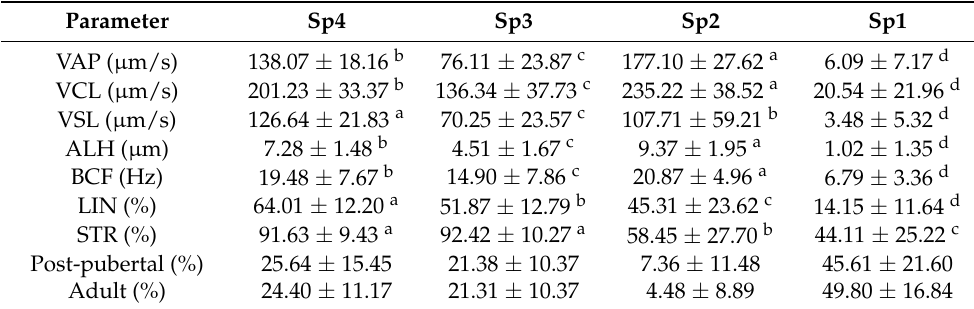
Table 4. Epididymal sperm motility subpopulations in <1-year-old (post-pubertal, n = 9) and >1-year-old (adult, n = 7) sexually mature tomcats.